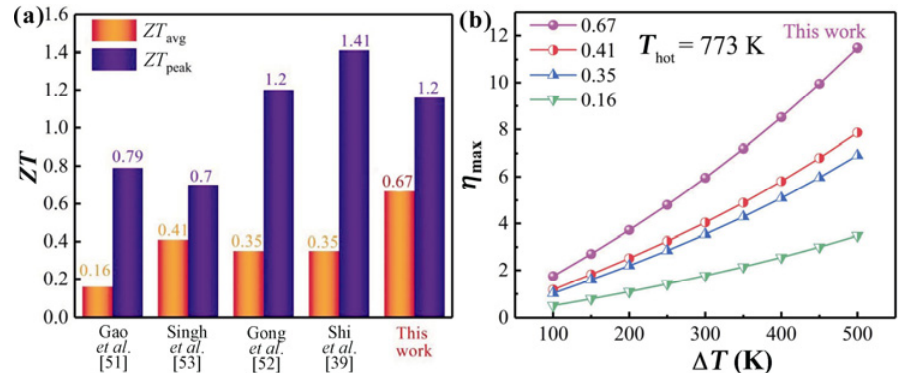
Fig. 12 (a) Comparison of both ZT peak and ZT avg with the reported single Cu-doped SnSe [39,51–53]. (b) Calculated single Cu-doped SnSe on the basis of